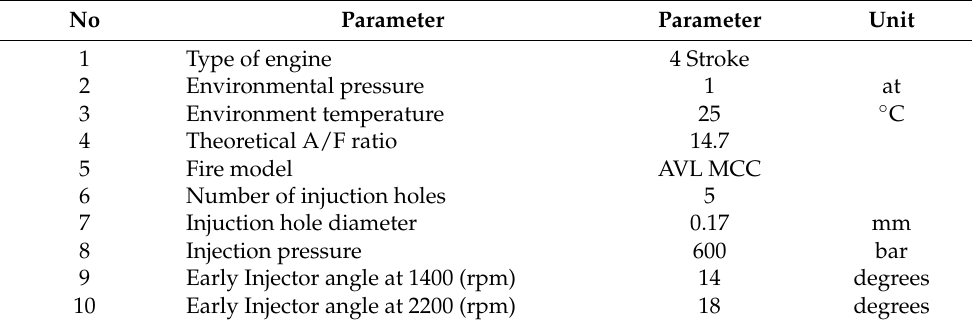
Table 6. General data controller model AVL-5402 engine.